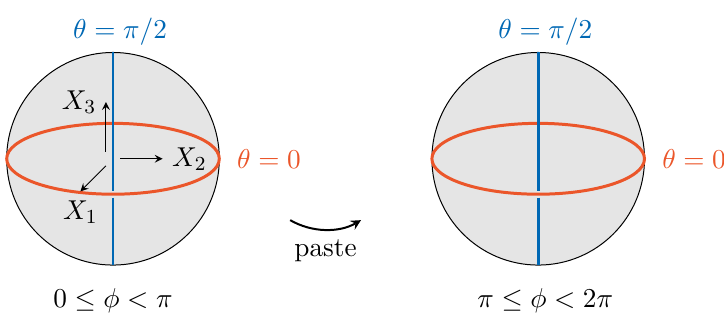
Figure 4 . The North (left) and South (right) hemisphere with two linked Wilson lines (orange and